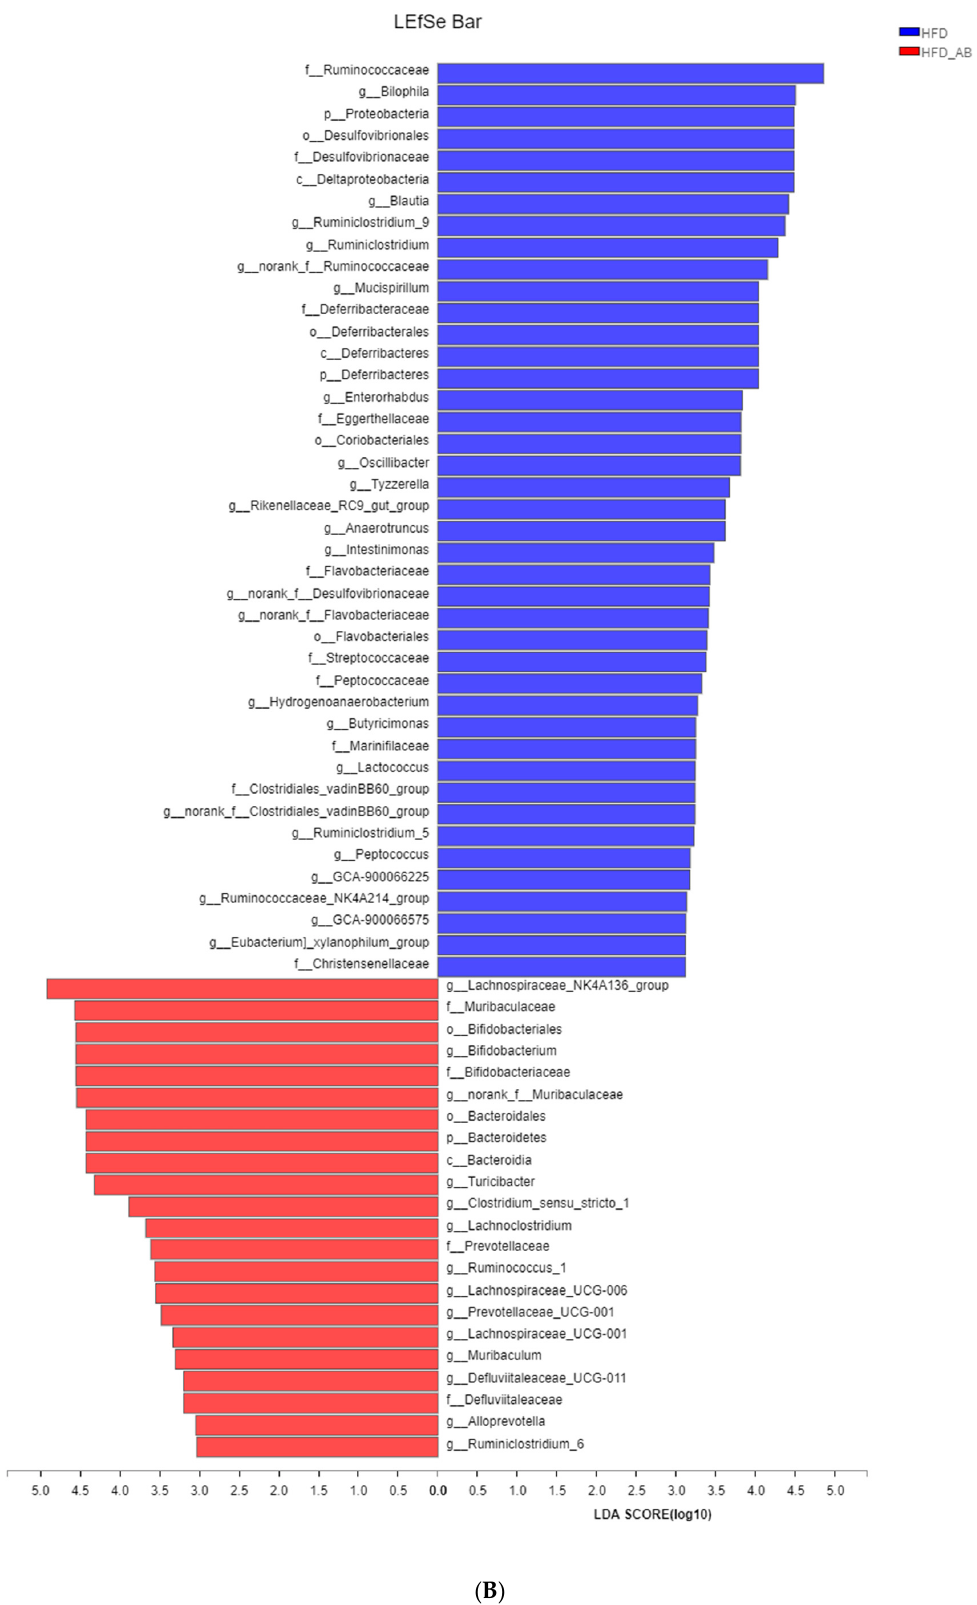
Figure 7. Key phylotypes of gut microbiota. ( A ) Cladogram generated from LEfSe analysis showing the relationship among taxons, and ( B ) linear discriminant analysis (LDA > 3) scores derived from LEfSe